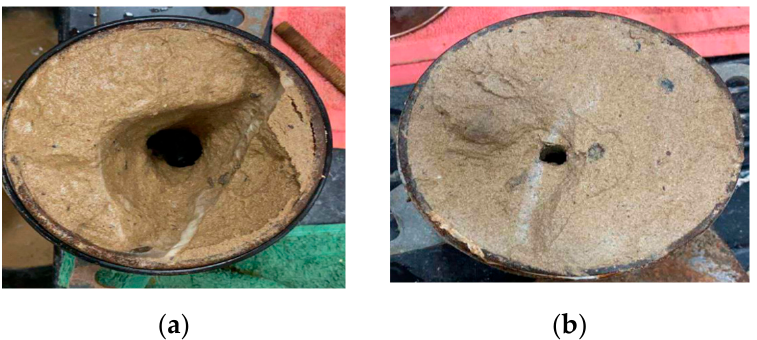
Figure 8. Final hole diameter ( φ f ) for some of the Soil #1 tested samples: ( a ) 1% lime at 1 day curing and ( b ) 5% lime at 2 days curing.